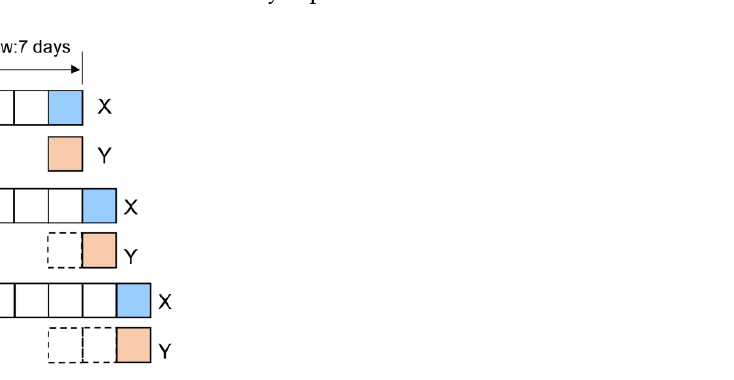
Figure 5. Schematic design of time sliding window in the construction of time-series data set.